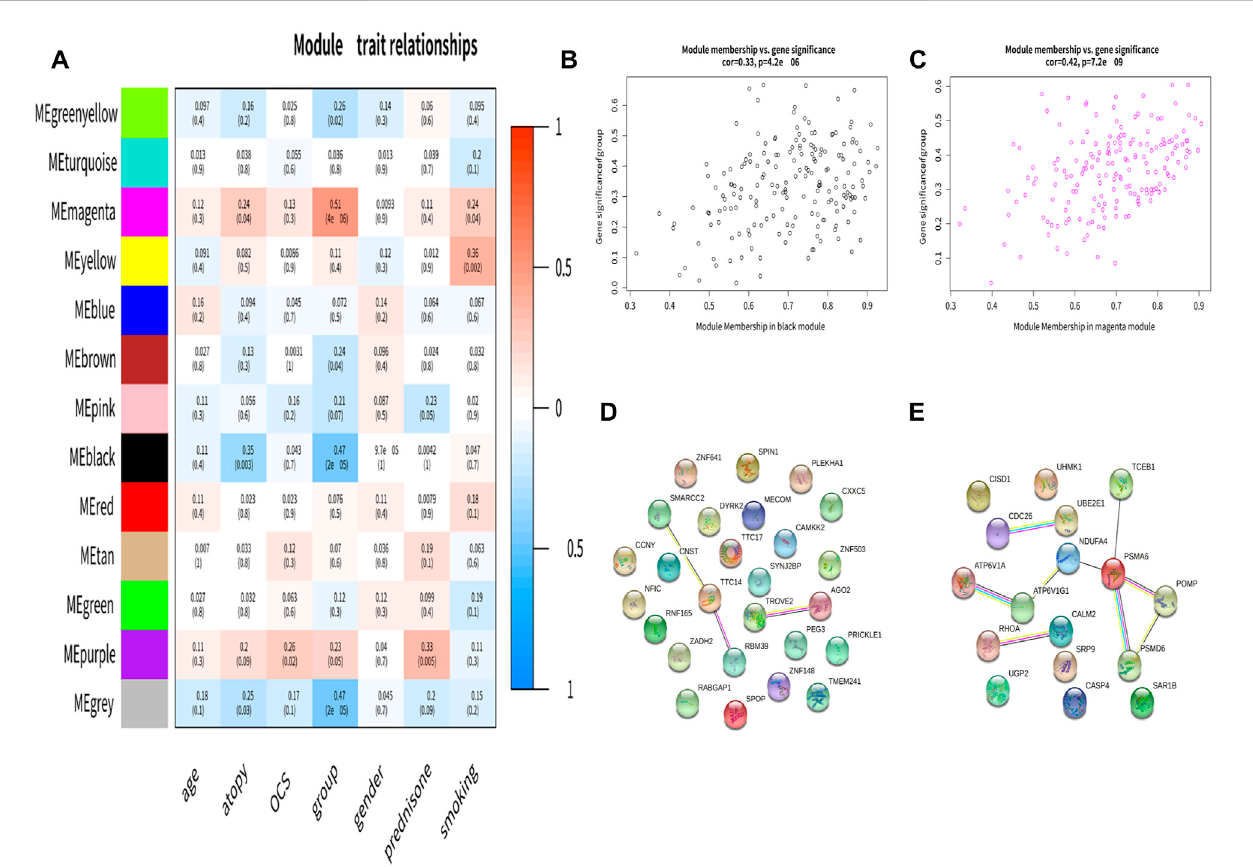
FIGURE 2 Identi fi cationof theclinically signi fi cantmodule andhub genes. (A) Module-traitassociations. Each rowcorrespondsto amoduleeigengene,column to aclinicaltrait. (B,C) AscatterplotofGeneSigni fi cance(GS)forasthmavs.ModuleMembership(MM)intheblackandmagentamodule. (D,E) ThePPInetworkin the black and magenta